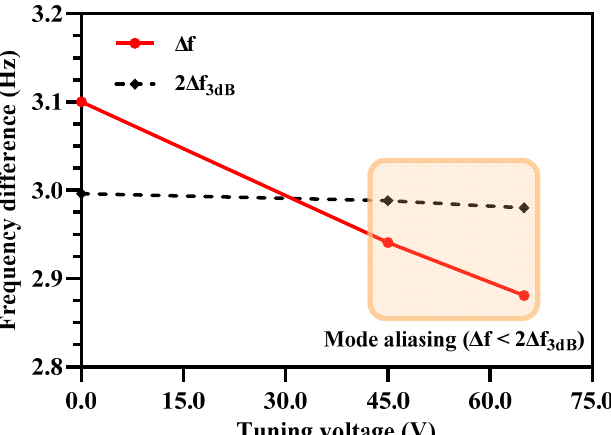
Figure 12. Effect of increasing tuning voltage on outer/inner resonators in Set A and Set B on the mode aliasing.